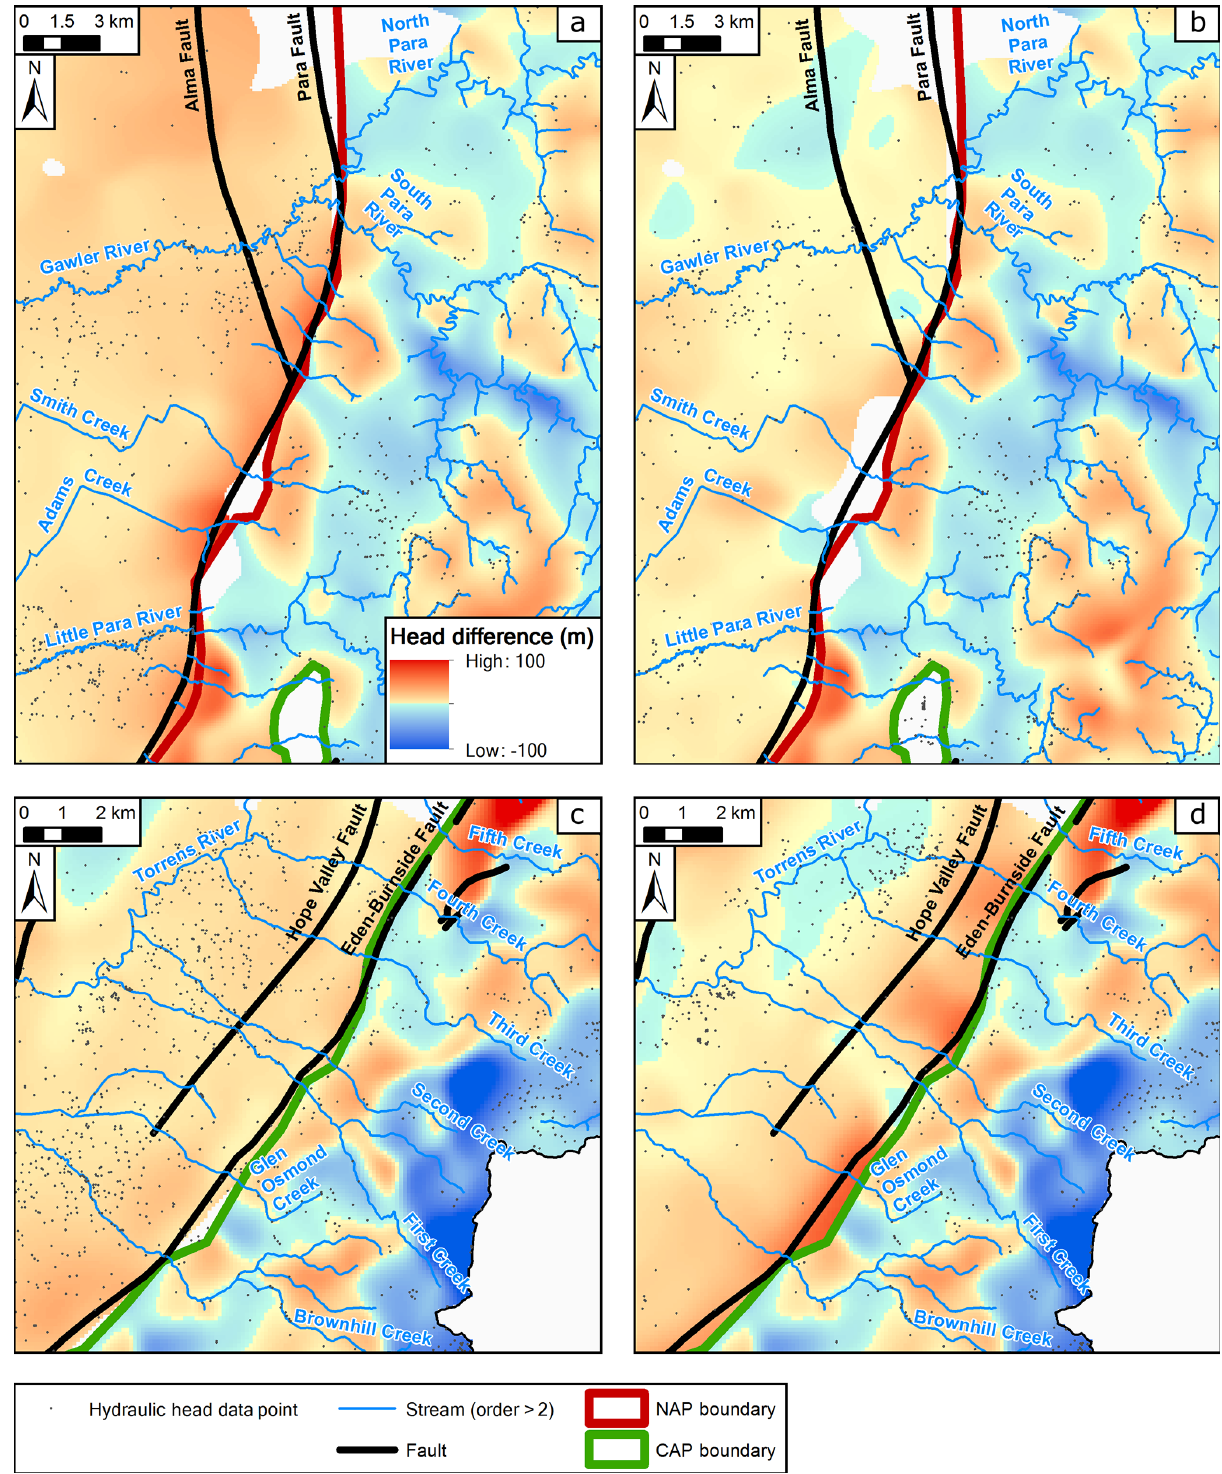
Figure 10. Head difference in the NAP (a–b) and CAP (c–d) focus areas. On the basin side, (a) and (c) show the nearest river head (approximated by topography) minus the head in the Quaternary aquifers, while (b) and (d) show the head in the Quaternary aquifers minus the head in the Tertiary aquifers. On the mountain side, all four sub-figures show the nearest river head minus the head in the Mount Lofty Ranges aquifers. The same colour scheme is applied everywhere and is indicated in (a) . Reddish colours are for positive values, indicating a potential for downward flow (i.e. groundwater recharge). Blueish colours are for negative values, indicating a potential for upward flow (i.e. groundwater